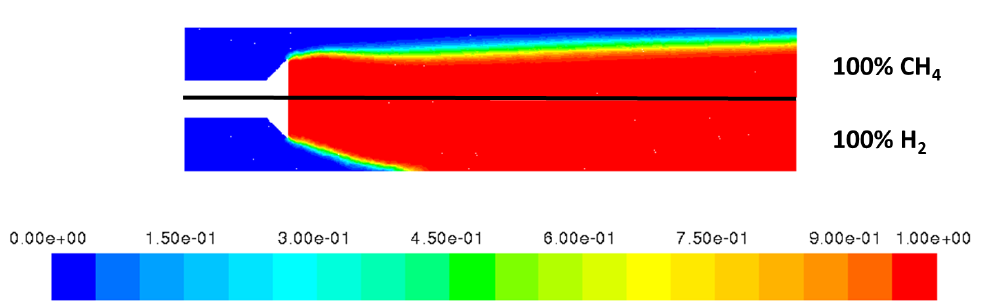
Figure 10. Contours of the progress variable θ for the two different mixtures: methane– air and hydrogen −